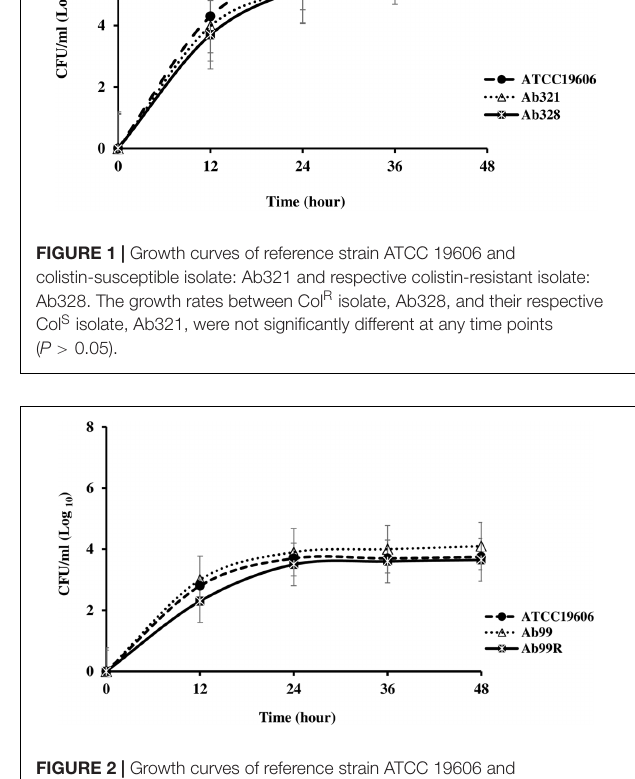
FIGURE 2 | Growth curves of reference strain ATCC 19606 and colistin-susceptible isolate: Ab99 and respective colistin-resistant isolate: Ab99R. The growth rates between Col R isolate, Ab99R, and their respective Col S isolate, Ab99, were not significantly different at any time points ( P > 0.05).